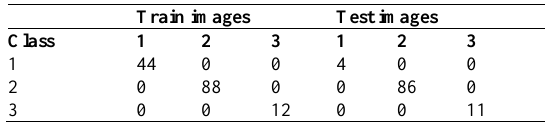
Table 5. Confusion matrix of atmospheric situations class detection for train and test